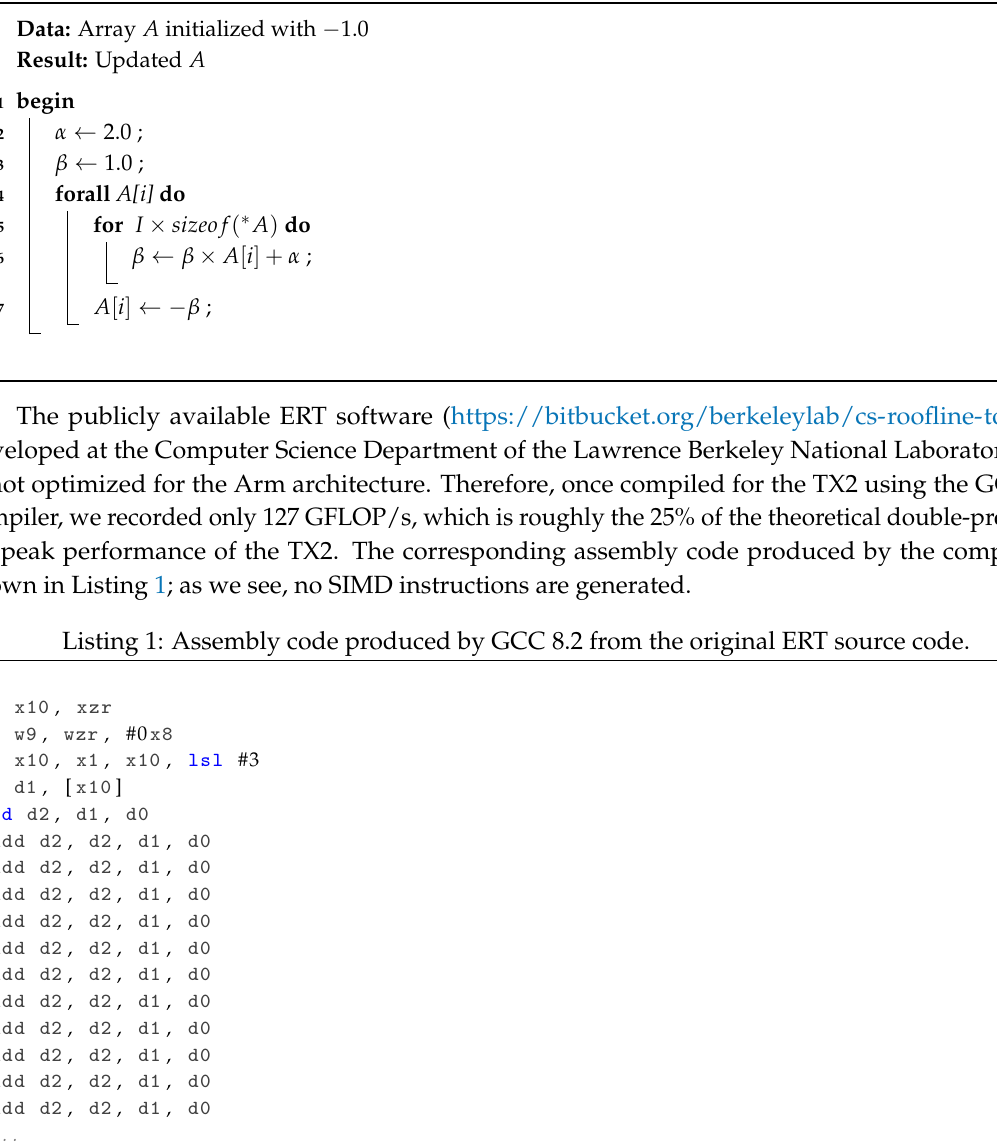
Algorithm 1: Original ERT main kernel